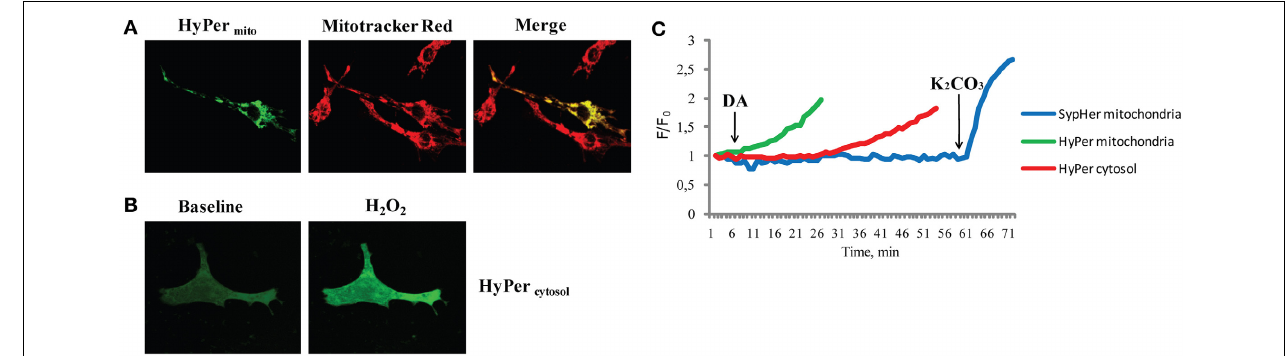
targeted HyPer (green line) increased shortly after the addition of MAO substrate dopamine (DA), wheras the cytosolic HyPer (red line) became oxidized only after prolonged incubation. In a separate experiment under the same conditions fluorescence of mitochondria targeted pH sensor SypHer (blue line) remained unchanged upon the addition of DA and increased only after matrix alkalinization with K 2 CO 3 . Reprinted by permission from Kaludercic et al.